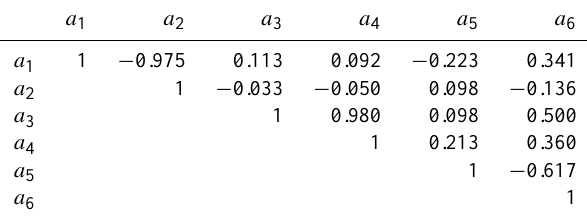
Table A1. Symmetric linear correlation matrix of fit parameters of Eq. (1) (normal compaction, no fluid flow). The number of fit- ted simulations is n = 104; χ 2 = 11315.7; variance of residuals is 115.5kgm − 2 ; linear correlation coefficient for GHI from model simulations and fitted equation is r 2 = 0.9971.